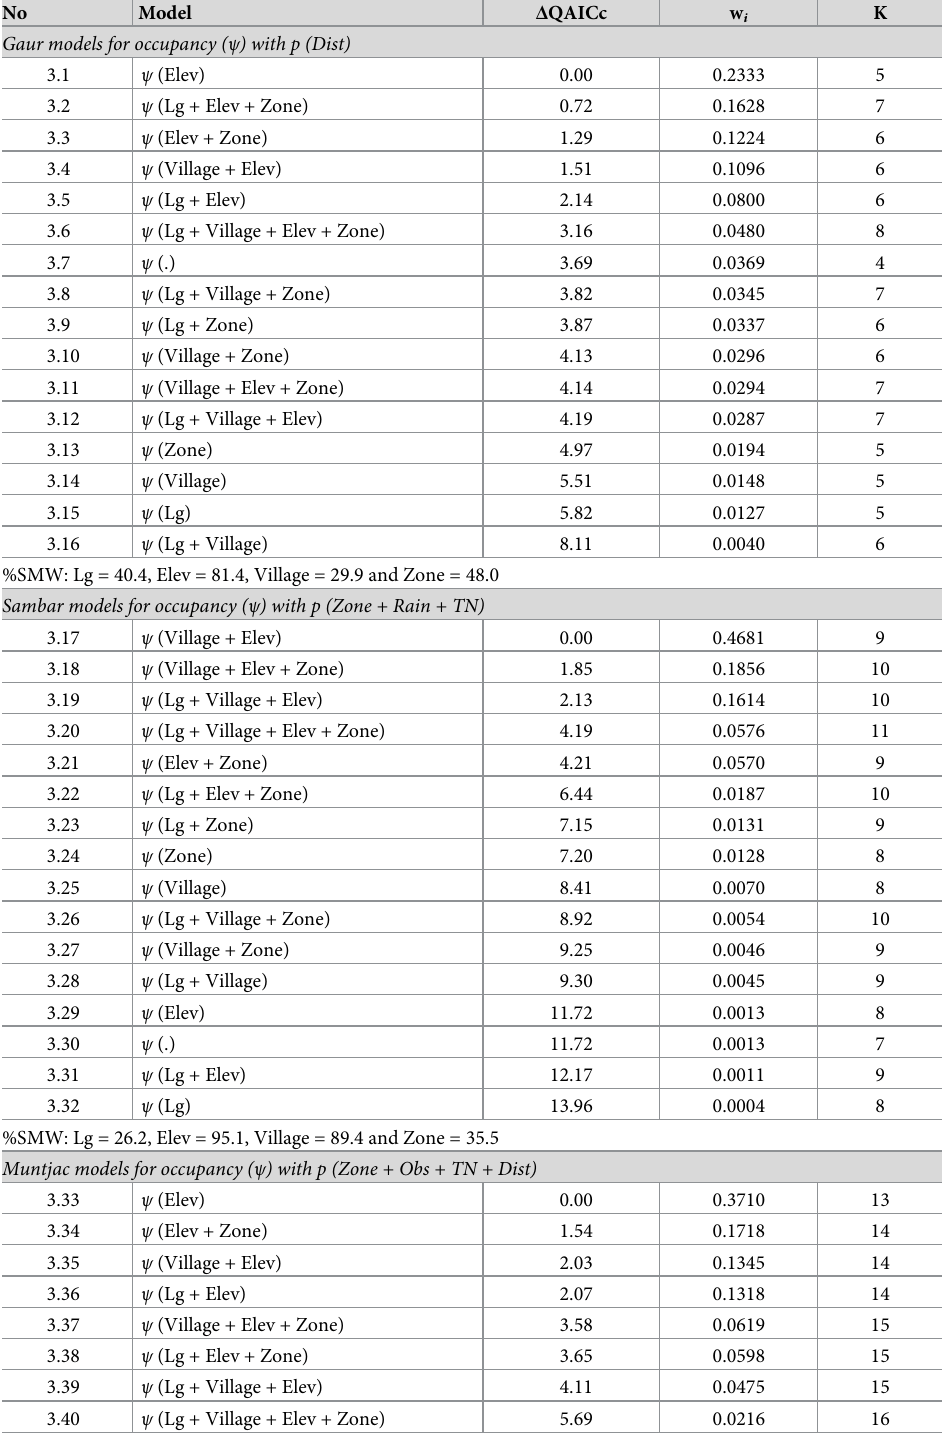
Table 1. Ungulate occupancy ( ψ ) models (w i > 0) and respective percentage of relative summed model weights (% SMW) for occupancy covariates in Temengor Forest Reserve and Royal Belum State